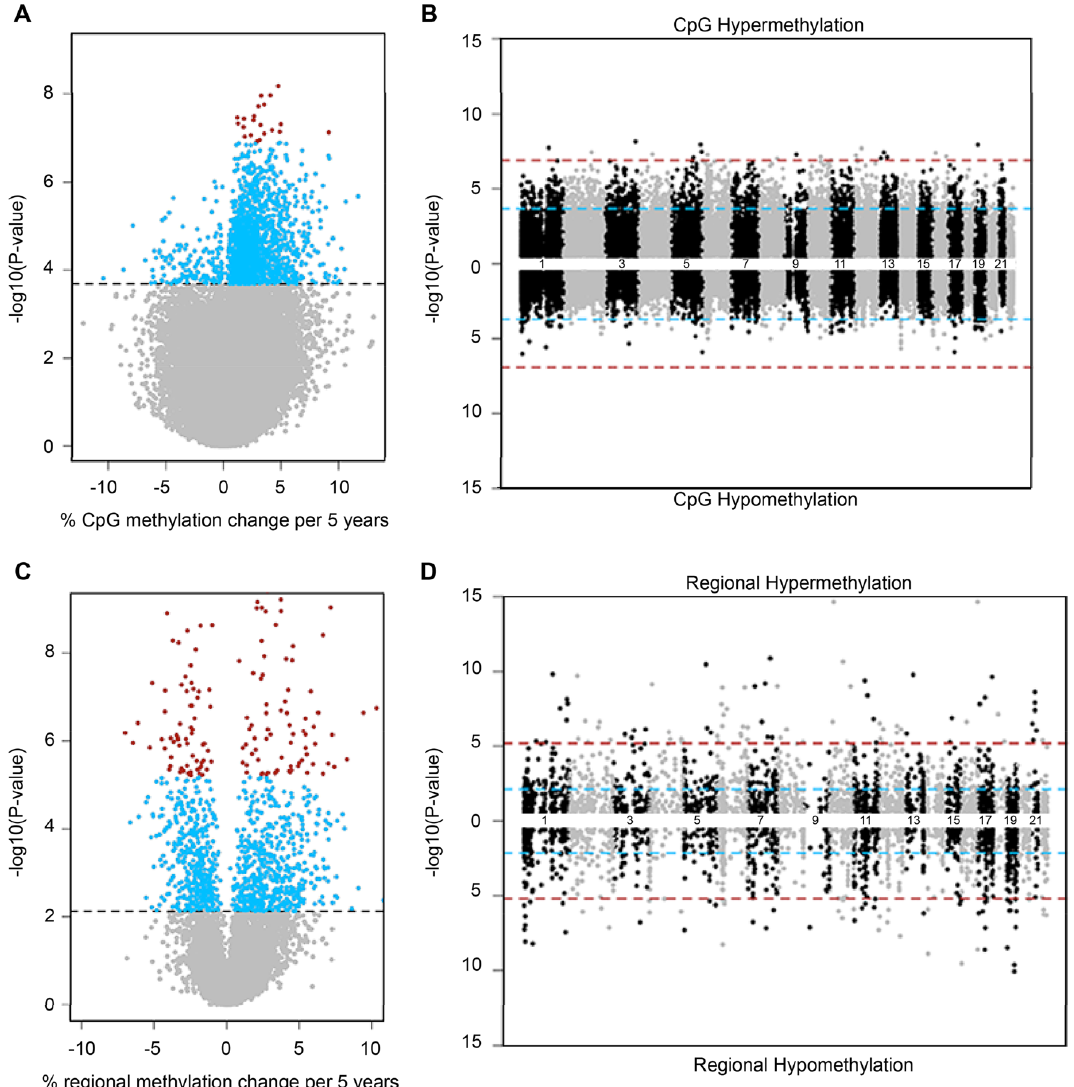
Figure 2. Volcano and Miami plots of age-associated sperm methylation at individual CpGs and regionally. Volcano plots show methylation change per 5 years of age adjusting for male BMI, infertility and smoking at ( A ) individual CpGs and ( C ) regionally where grey, blue and red-colored data points representing non-significant, FDR significant, and Bonferroni significant, respectively. Miami plots show the chromosomal distribution of age-associated sperm methylation at ( B ) individual CpGs and ( D ) regionally where blue and red dashed lines represent FDR and Bonferroni cut-off levels,